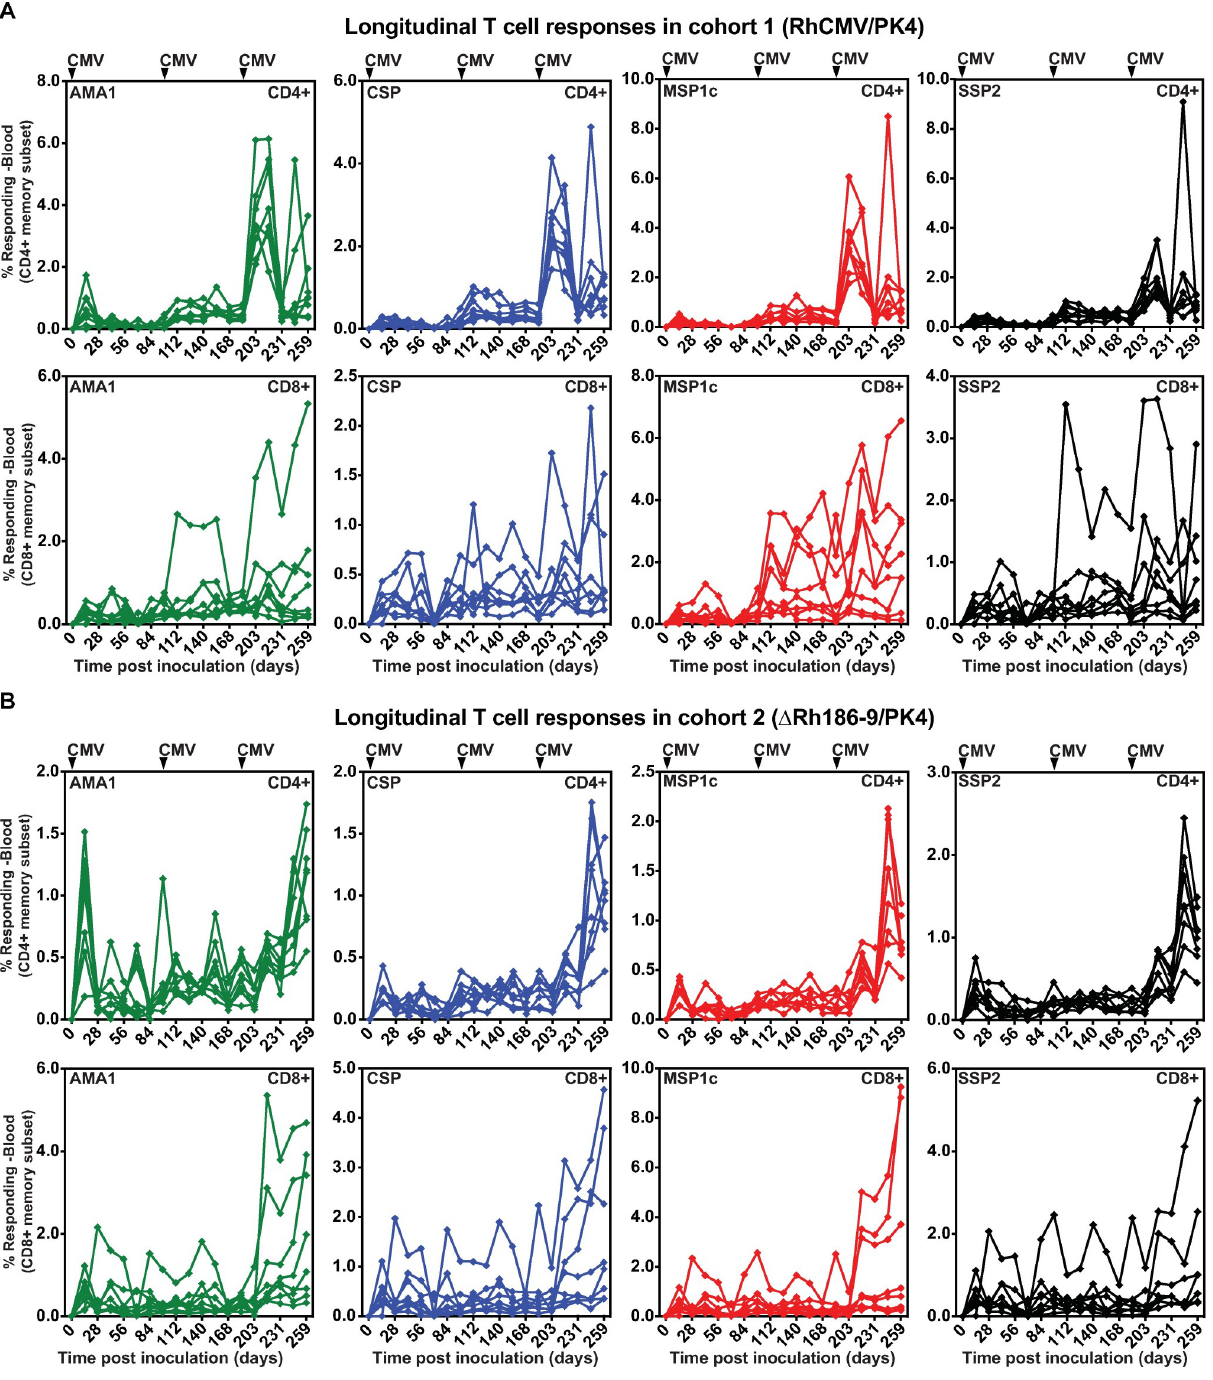
Fig 2. T cell responses to Pk antigens. Frequencies of Pk Ag-specific CD4+ and CD8+ T cells in the blood of animals inoculated with 5x10 6 PFU of each of the four RhCMV/PK4 recombinants (A) or Δ Rh186-9/PK4 recombinants (B) at day 0 and with RhCMV/PK4 on days 98 and 189. The percentage of CD4+ or CD8+ T cells (corrected for memory T cells) responding to each of the four Pk antigens were measured by ICS using overlapping peptide pools at the indicated days. T cell responses are shown for each antigen in each individual animal over time.